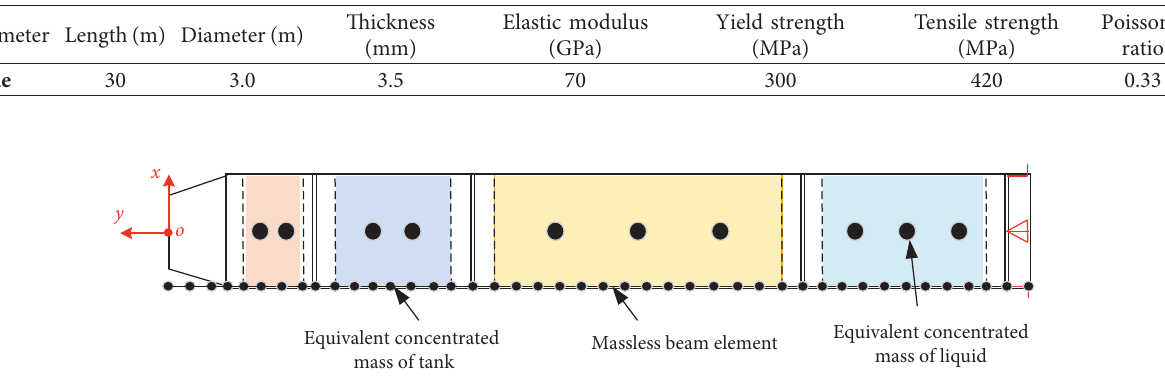
Figure 3: Mechanical model of the liquid storage tank (the springs are